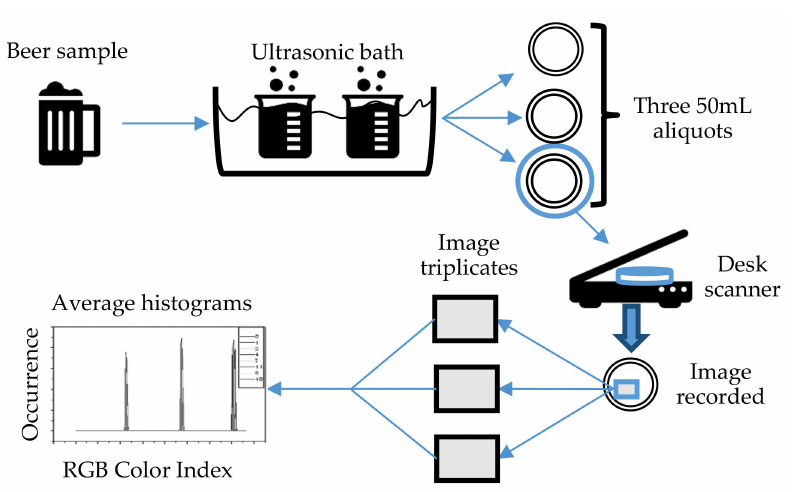
Figure 15. Procedure for obtaining the image data matrix.